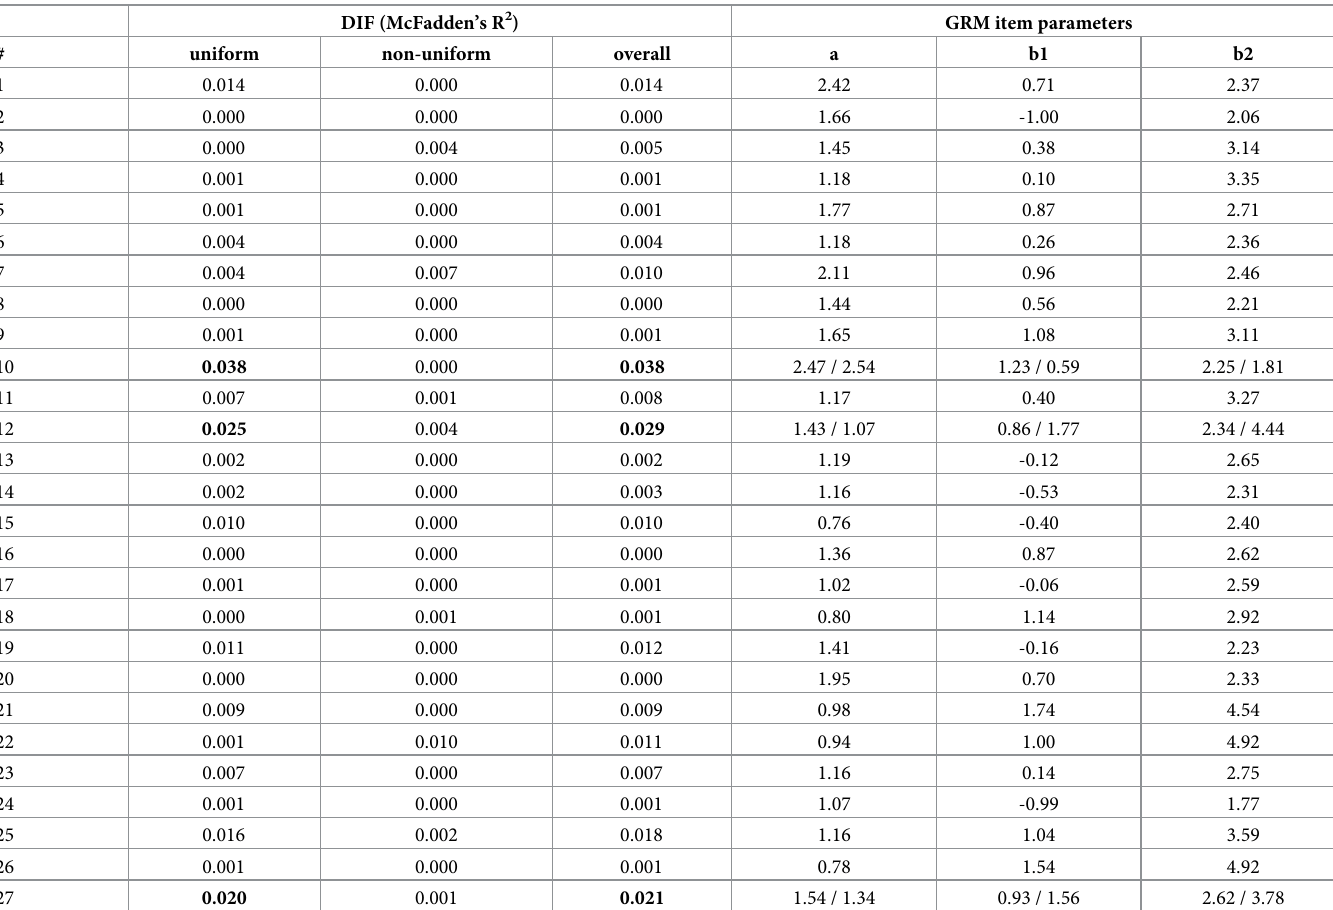
Table 5. Results of DIF analysis and GRM item parameters (N =